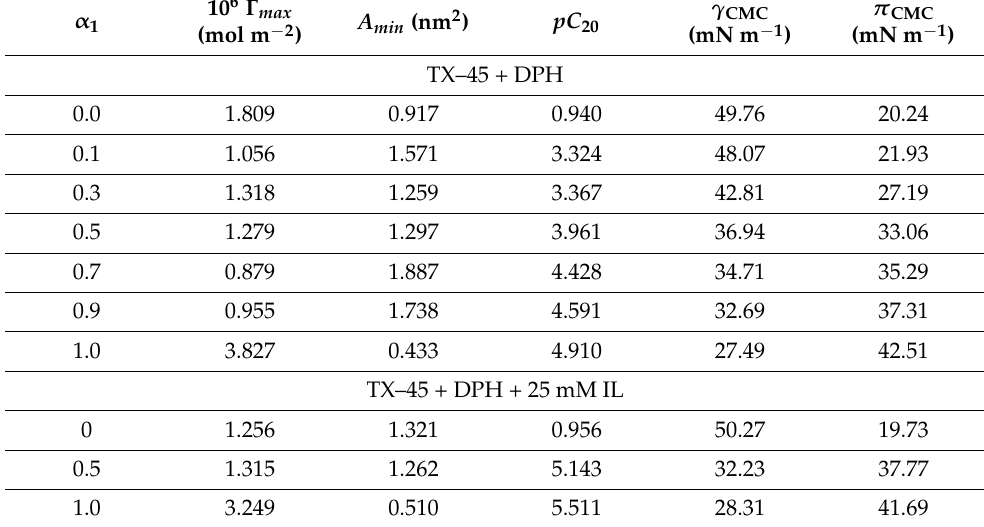
Table 2. Surface parameters of TX–45 and DPH mixtures in the attendance and non-atendance of 25 mM IL at T = 298.15 K